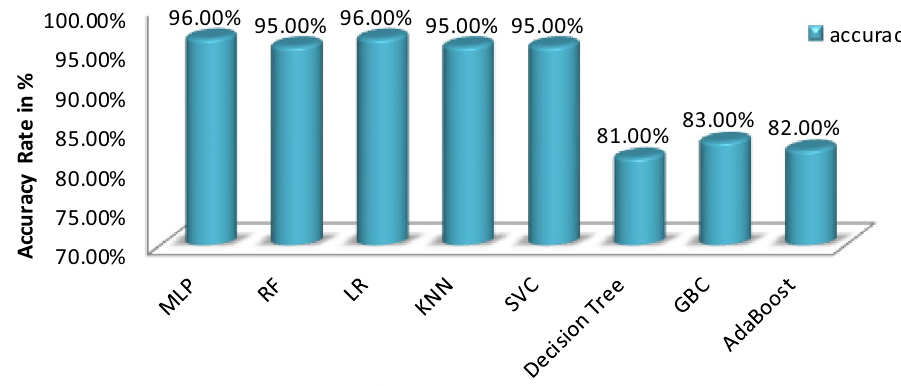
Fig. 10 Lowest accuracy com- parison of different classifica- tion algorithms